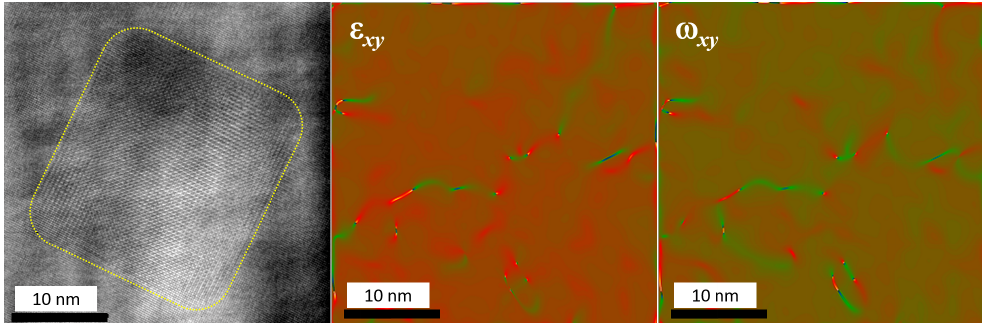
Figure 5. HR-TEM of Al 3 Sc-based precipitate (left panel) with the results of a geometric phase analy- sis showing in-plain shear, (cid:101) xy , (central panel) and rotational ω xy , (right panel) strain components. The precipitate is schematically outlined (left